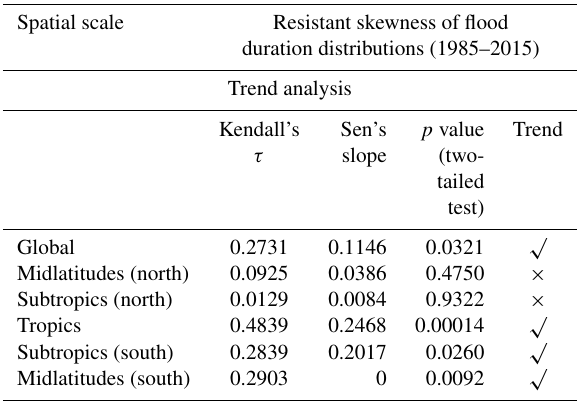
Table 5. Same as Table 2 but for the resistant skewness of flood duration